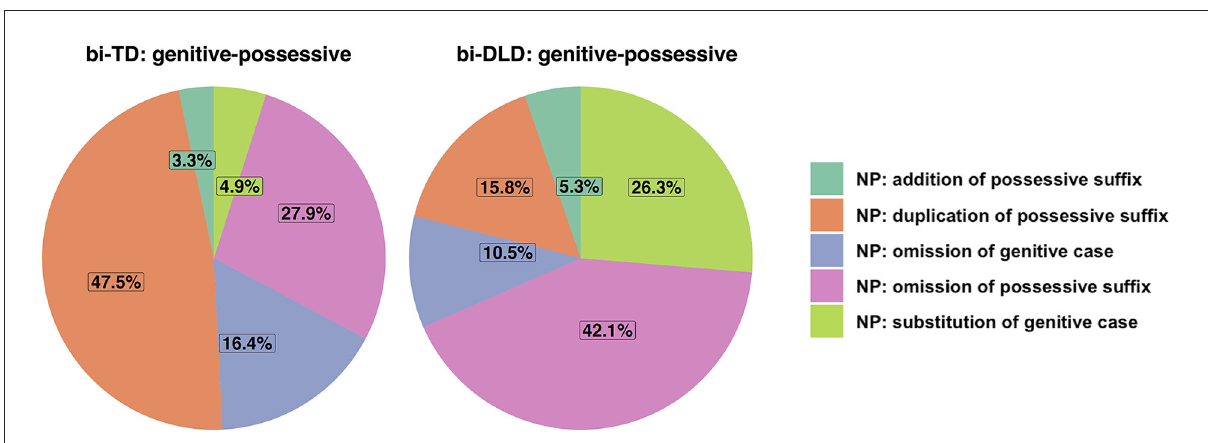
FIGURE2 Distributions of genitive-possessive errors in Turkish in the bi-TD and bi-DLD